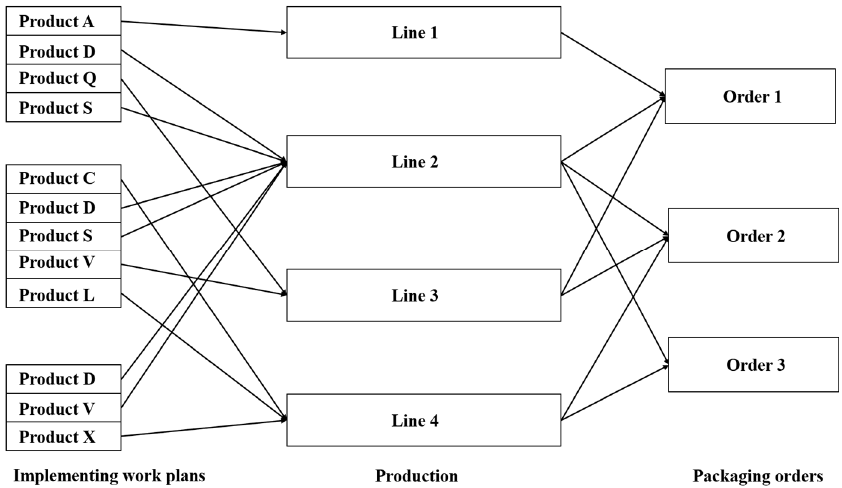
Figure 3. Manufacturing system diagram of Enterprise Q.